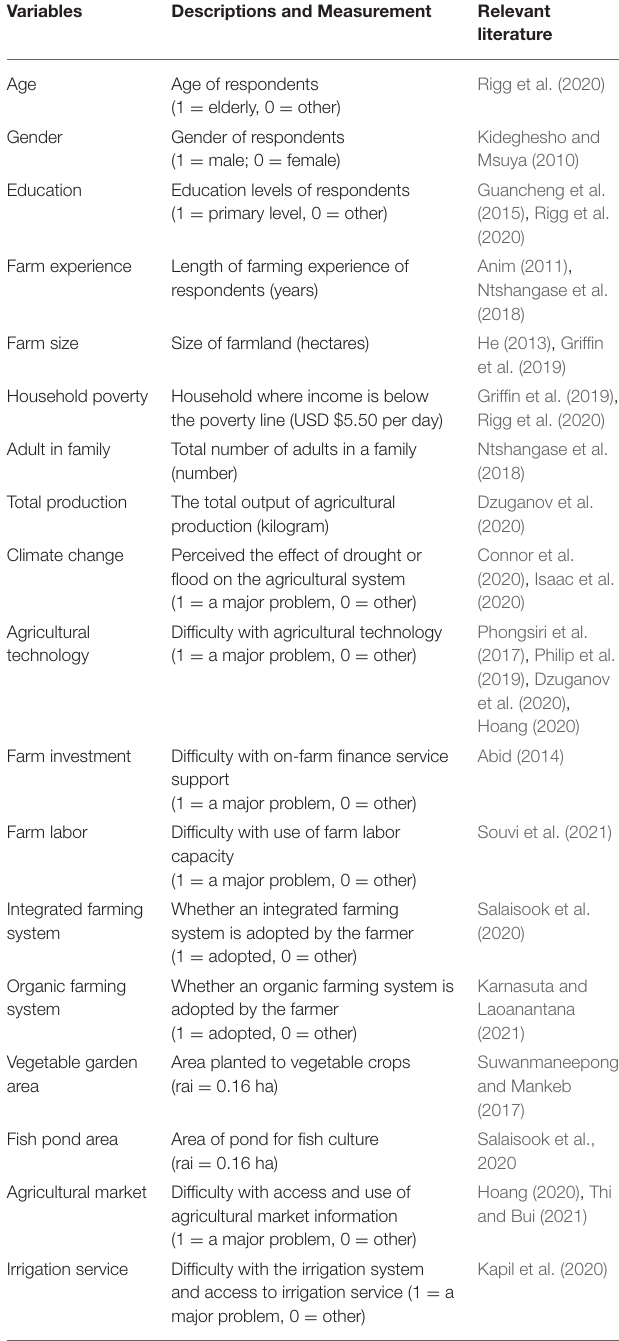
TABLE 2 | Selected variables, their description, measurement and relevant reference